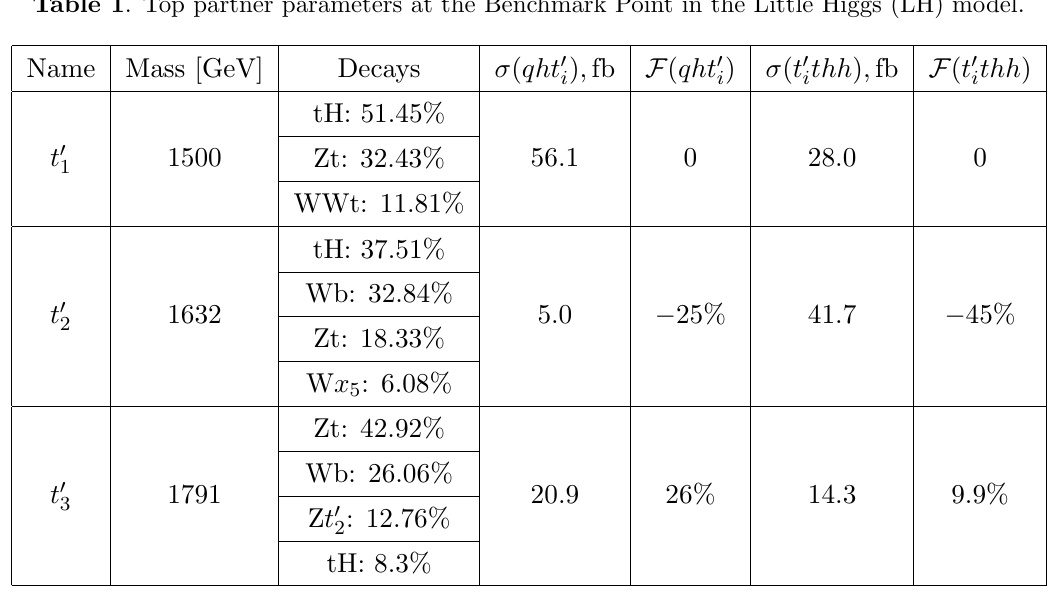
Table 2 . Top partner parameters at the Benchmark Point in the Maximally Symmetric Composite Higgs (MSCH)